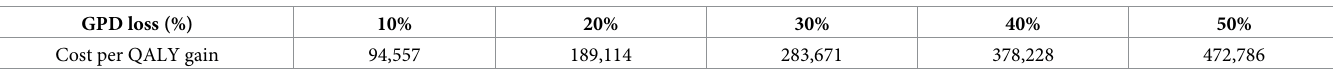
Table 3. Costs per QALY gain for lockdown with various levels of GDP loss due to lockdown.